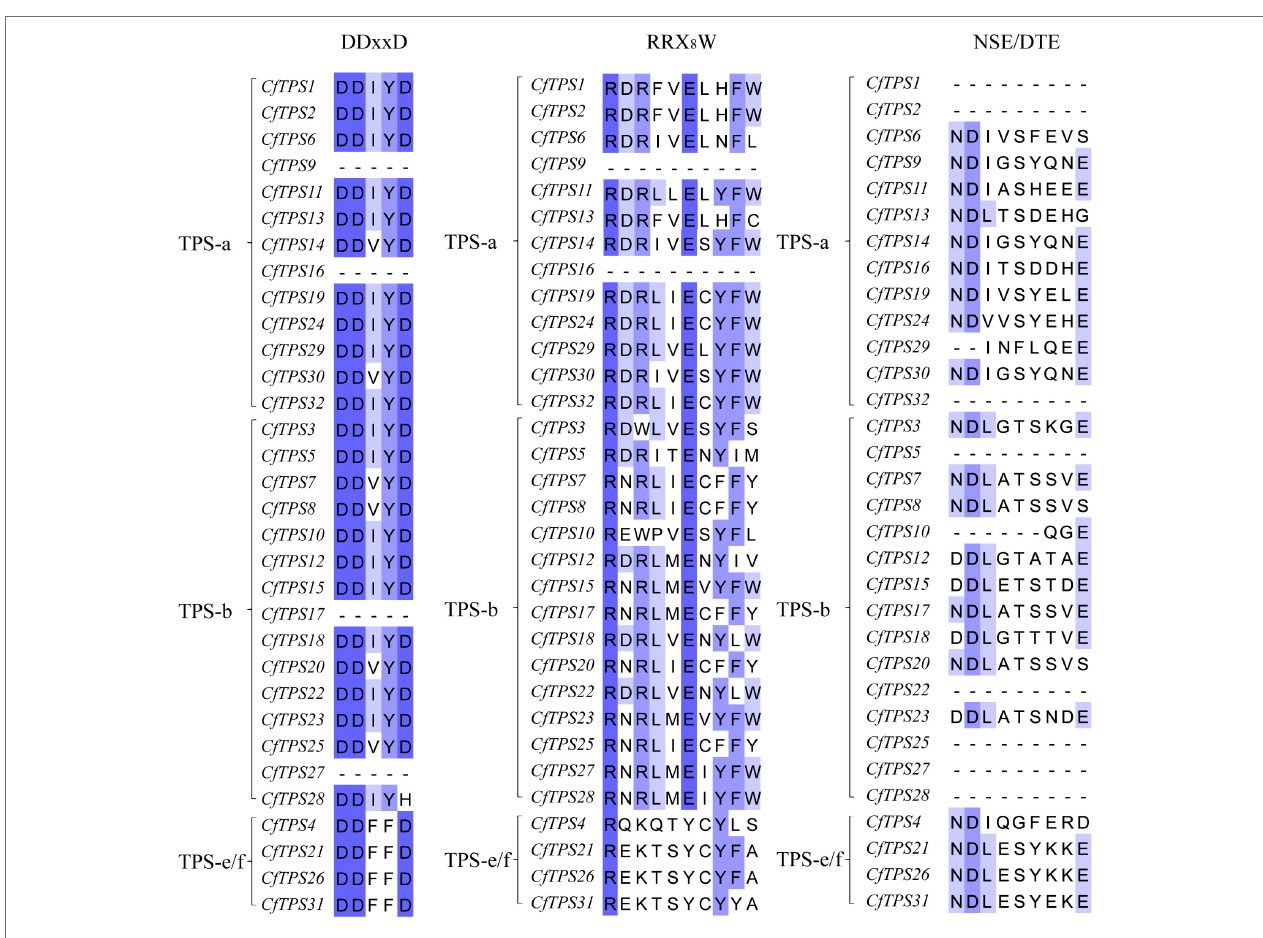
FIGURE 4 | RRX 8 W, DDxD, and NSE/DTE motifs in the CfTPS protein amino acid sequences. Multiple sequence alignments were constructed by MAFFT, and Jalview software was used to visualize the sequences (Troshin et al., 2011; Rozewicki et al.,